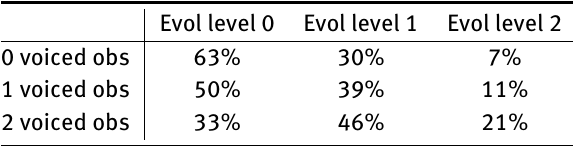
Table 2: The effects of voiced obstruents on the evolution levels in Pokémon